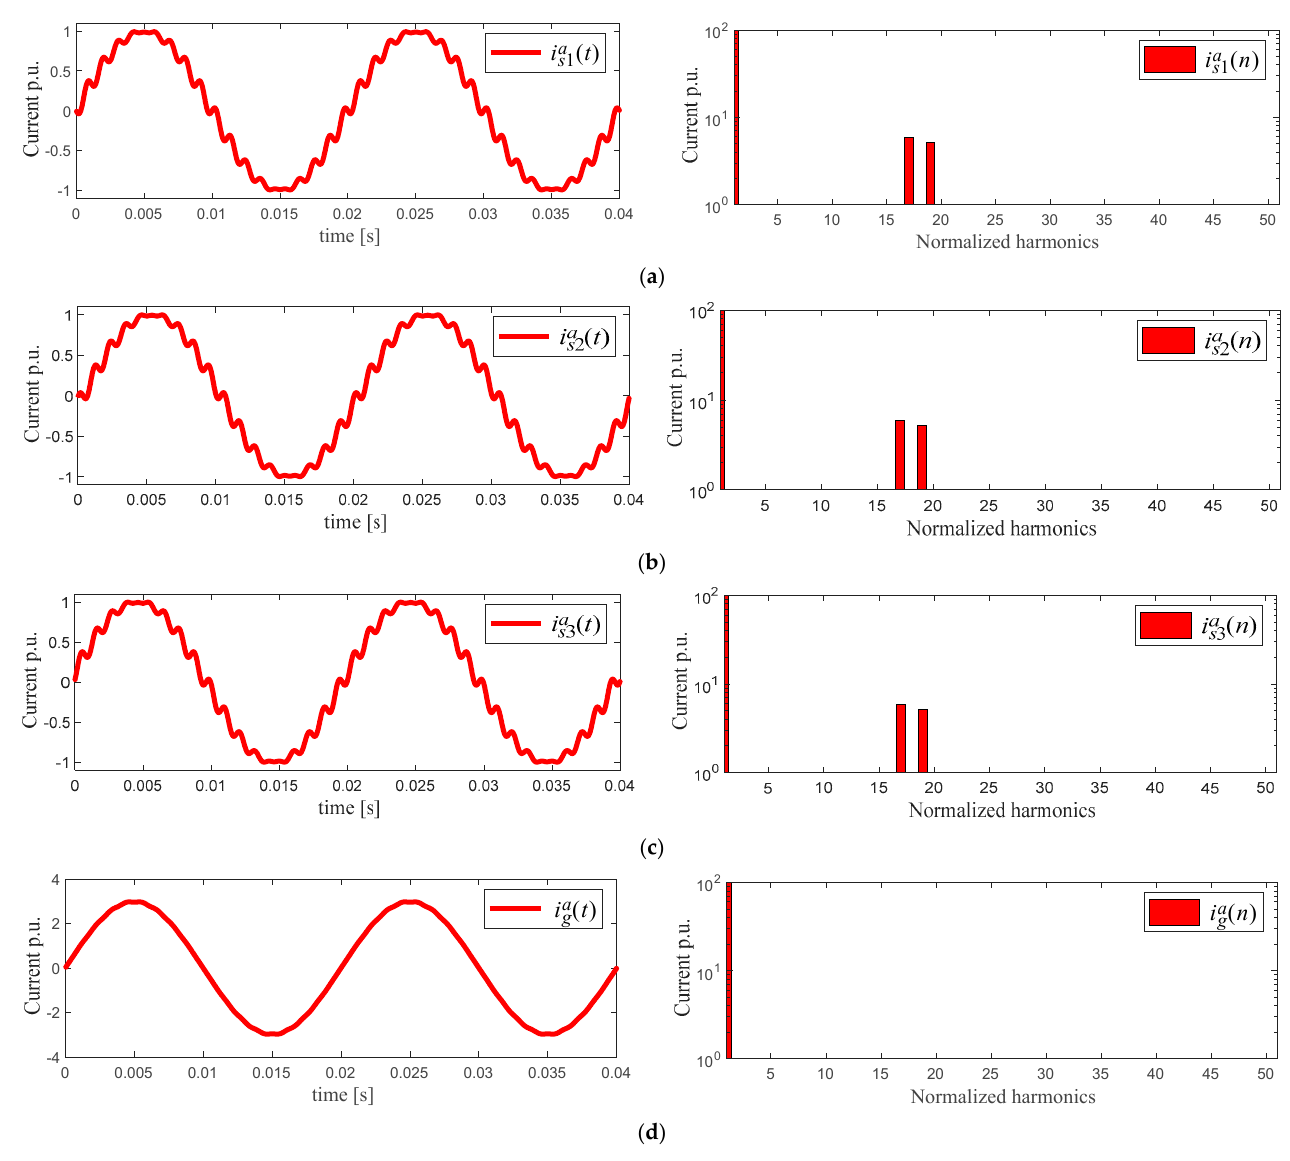
Figure 2. Input current references and harmonic content AFE rectifier for phase a . ( a ) AFE rectifier 1, ( b ) AFE rectifier 2, ( c ) AFE rectifier 3, ( d ) input current multi-cell AFE rectifier. THD minimization of the overall input current in the multicell AFE rectifier is per- formed using the expression defined by,